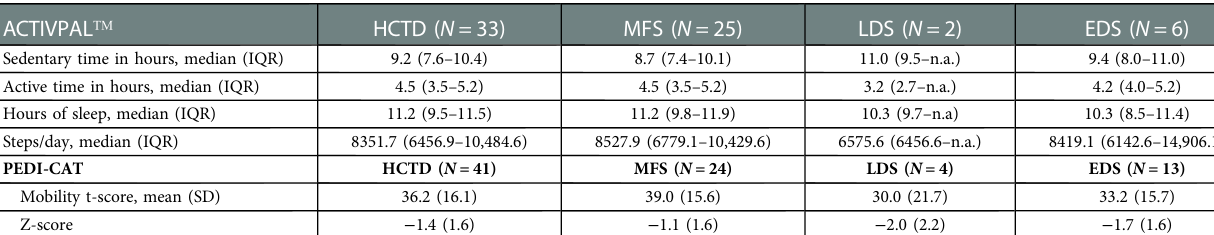
TABLE 2 Physical activity in children with